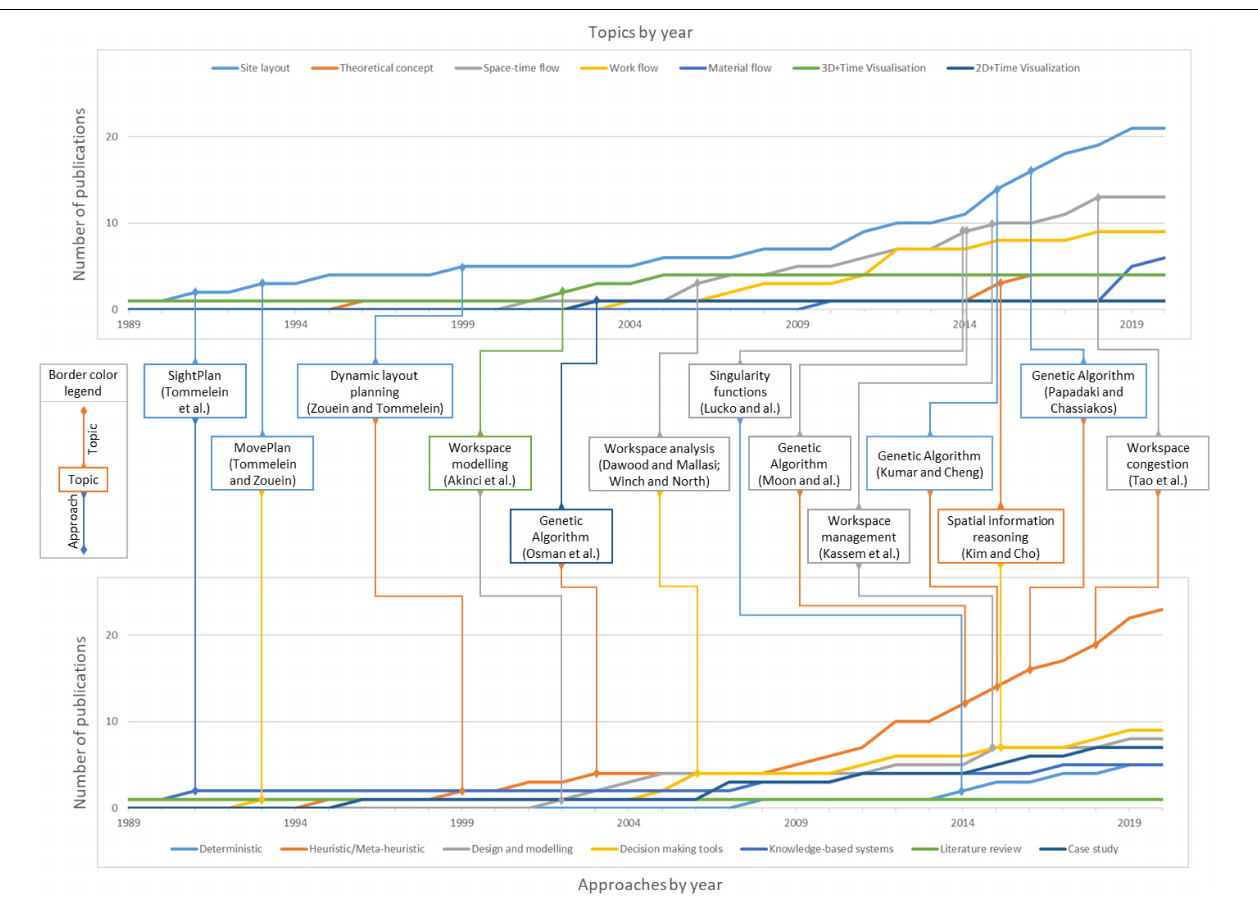
FIGURE 4 | Timeline of research on spatiotemporal planning—Mathematical, decision systems and empirical